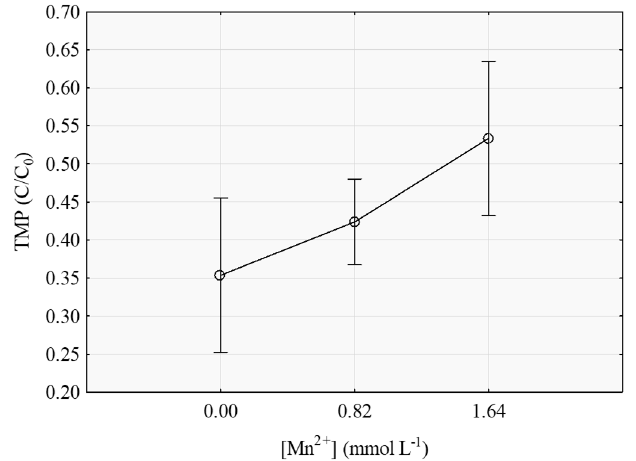
Figure 3. Graph of the global average of the relative concentration of TMP in all runs tested, for the three levels tested of [Mn 2+ ].